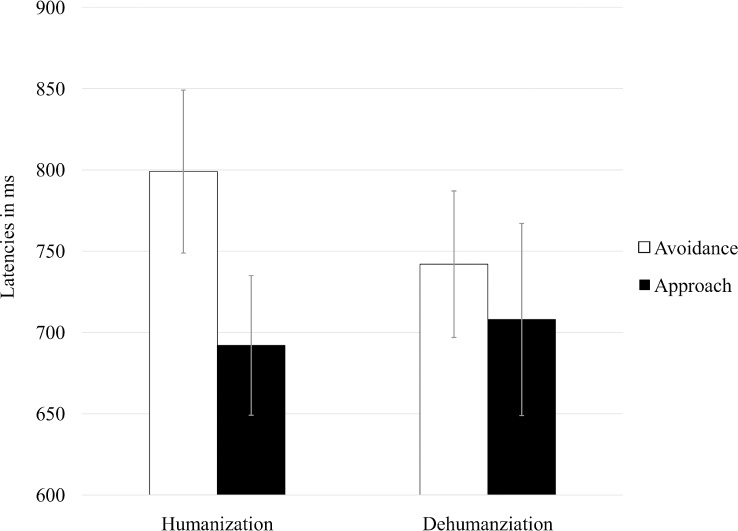
Mean latency scores as a function of the condition (humanization vs. dehumanization) and the type of action (approach vs. avoidance), Study 1.Note: Bars represent 95% confidence intervals.